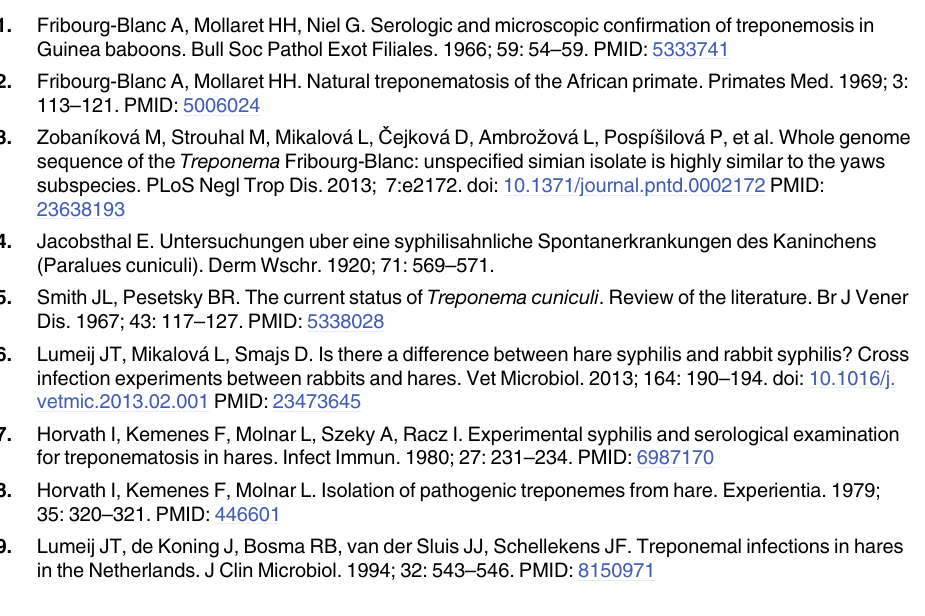
S1 Table. Chromosomal paralogous regions not included in the automated analysis of Illu- mina sequencing reads of the TPA Nichols genome. S2 Table. Chromosomal paralogous regions not included in the automated analyses of Illu- mina sequencing reads of all investigated genomes. S3 Table. A set of 23 putative heterogeneous positions identified solely by the Illumina workflow, but not verified by other sequencing methods. S4 Table. Primers used for DNA amplification and Sanger sequencing of 26 heterogeneous candidate positions (not-verified by 454 workflow). S5 Table. List of primers used for DNA amplification and Sanger sequencing of selected intrastrain heterogeneous sites in four different TPA SS14 DNA